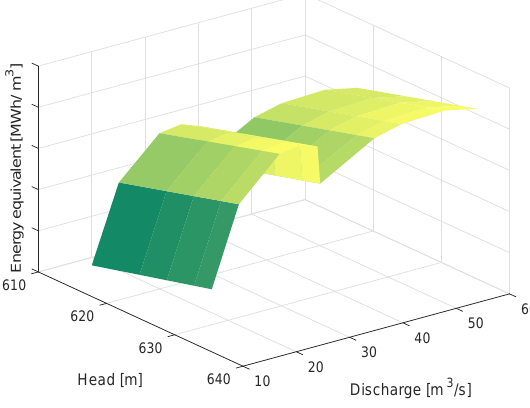
Figure 1. A generation function dependent on net head and discharge. For the purposes of illustration, the z-axis is given by the energy equivalent [MWh/m 3